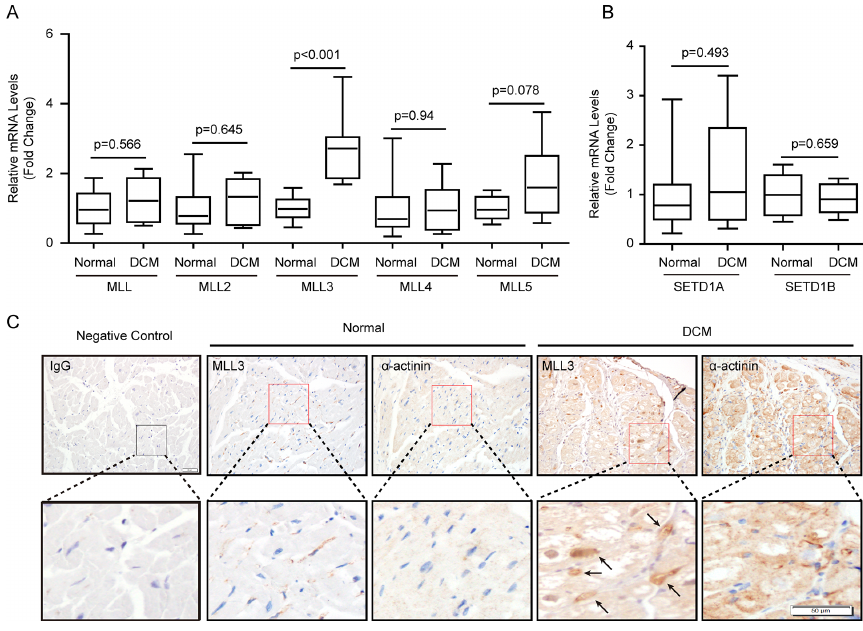
Figure 3. MLL3 expression level was increased in human DCM hearts. (A,B) The mRNA levels of MLLs were detected by real-time PCR (n = 8 per experimental group). (C) Specific immuno- histochemistry staining of MLL3 and α -actinin in the left ventricles of human hearts. Black ar- rows indicate MLL3-positive cardiomyocytes (n = 4 per experimental group, scale bar 50 μ m).